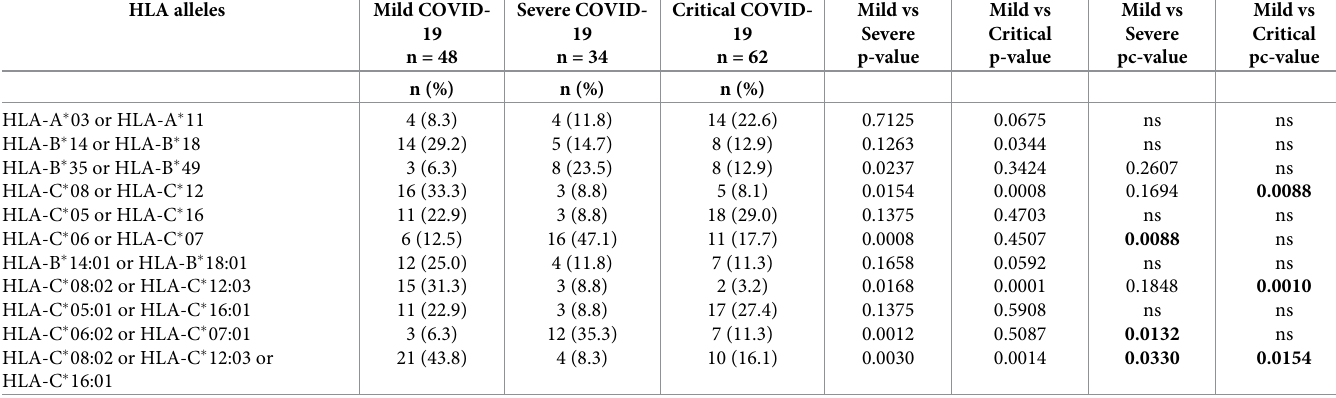
Table 3. Frequency of the associations between specific HLA class I alleles that may interact with KIR in individuals with mild, severe and critical COVID-19. The statistical significance of the comparisons between the frequencies of these allele combinations in the groups of individuals with severe and critical COVID-19 and the group of individuals with mild COVID-19 was calculated using Fisher’s exact test or chi-square 2x2. Significance levels were corrected by Bonferroni correction. Significant pc < 0.05 are highlighted in bold font. HLA alleles